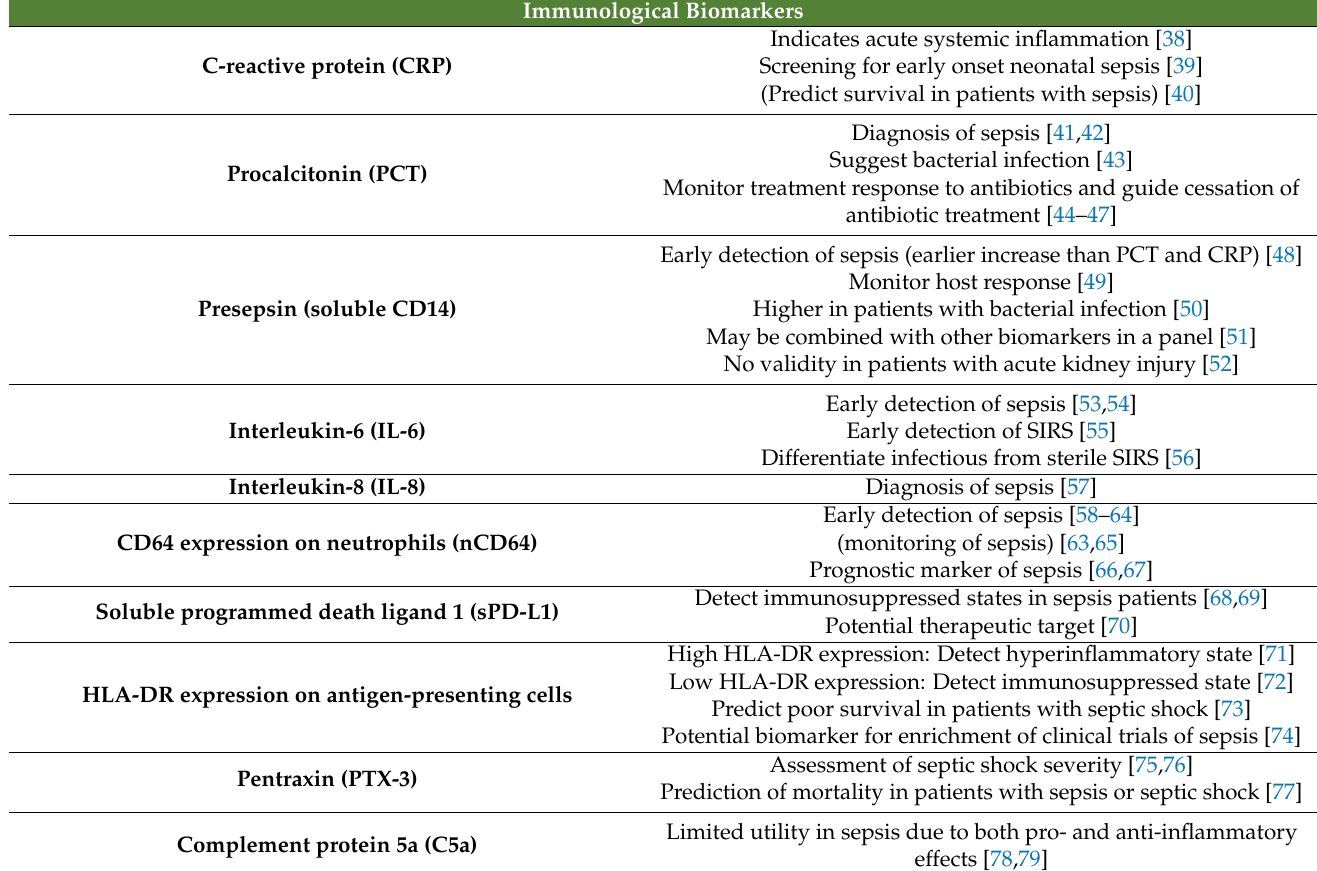
Table 1. Biomarkers with potential application in sepsis or septic